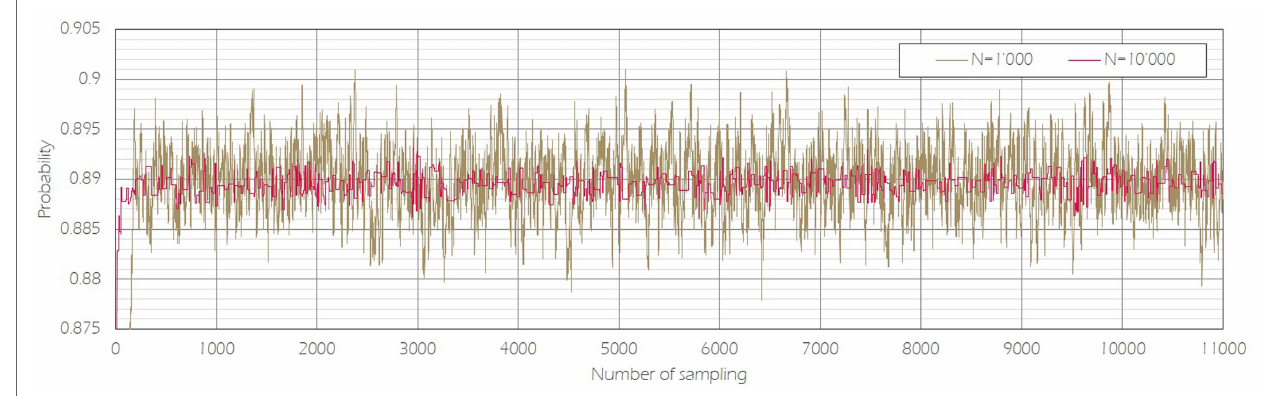
FIGURE 6 | Sampling of parameter π